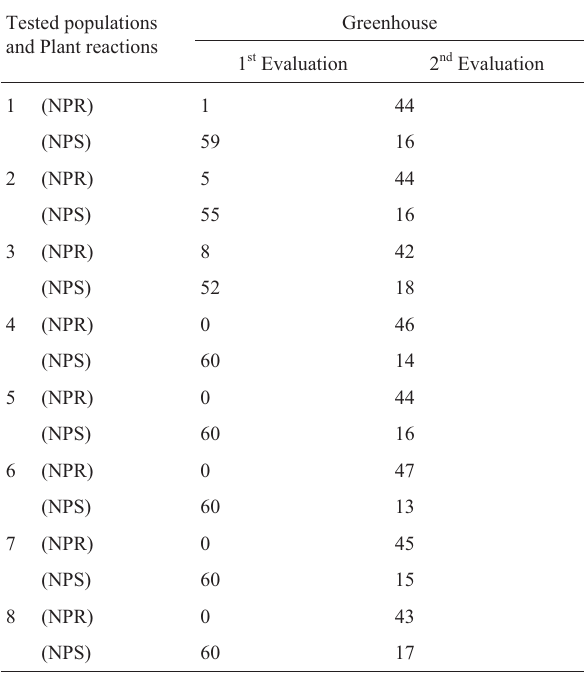
Table III - Result of the χ 2 test for the crosses evaluated in terms of reaction to powdery mildew.